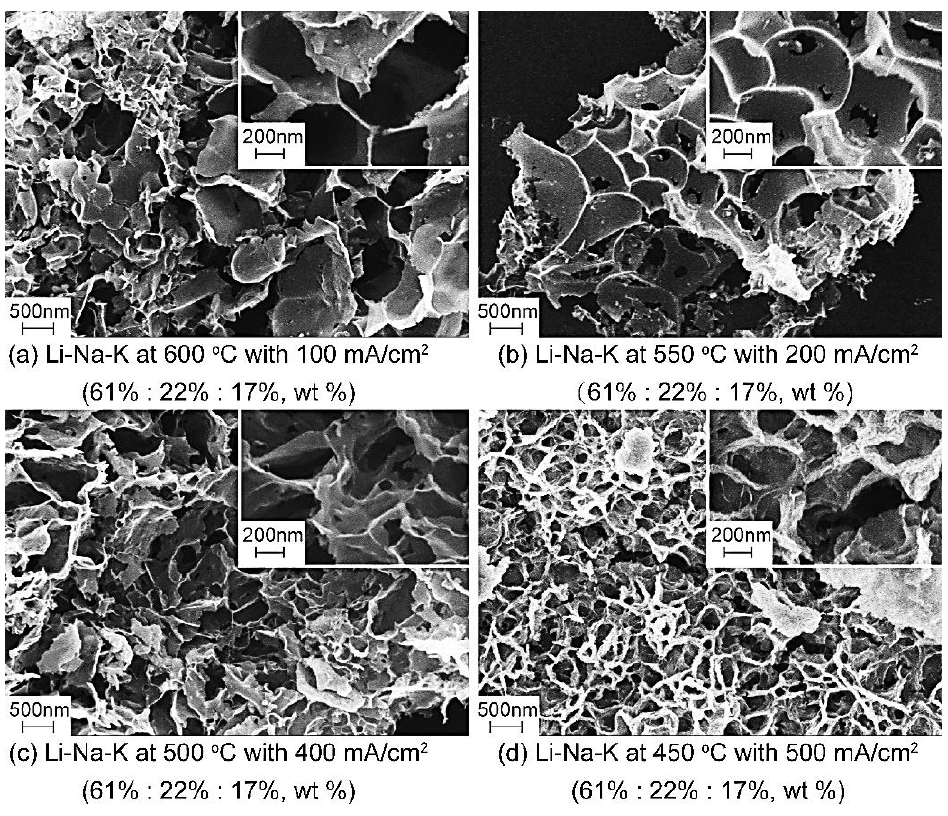
Figure 5. Cellular porous carbon obtained from Li 2 CO 3 + Na 2 CO 3 + K 2 CO 3 eutectic carbonates under different conditions.